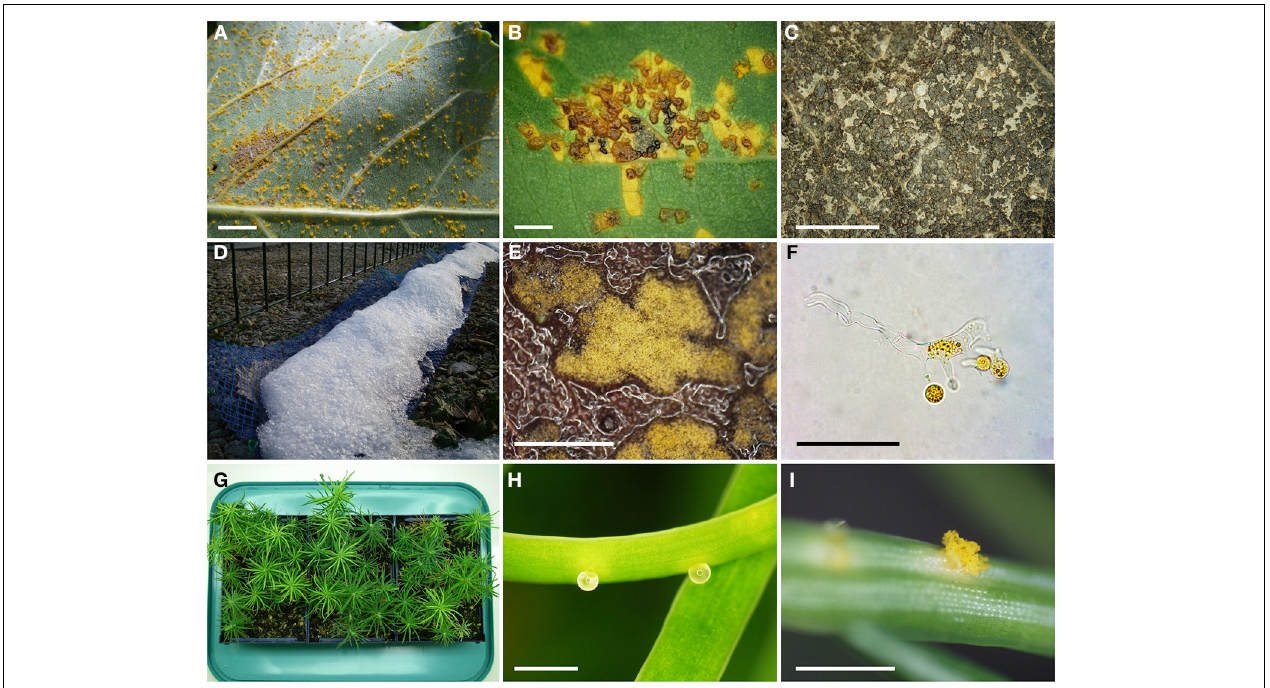
poplar leaves in the plastic mesh bags. (E) Telia producing basidia and basidiospores (scale bar 1mm). (F) Basidium producing four